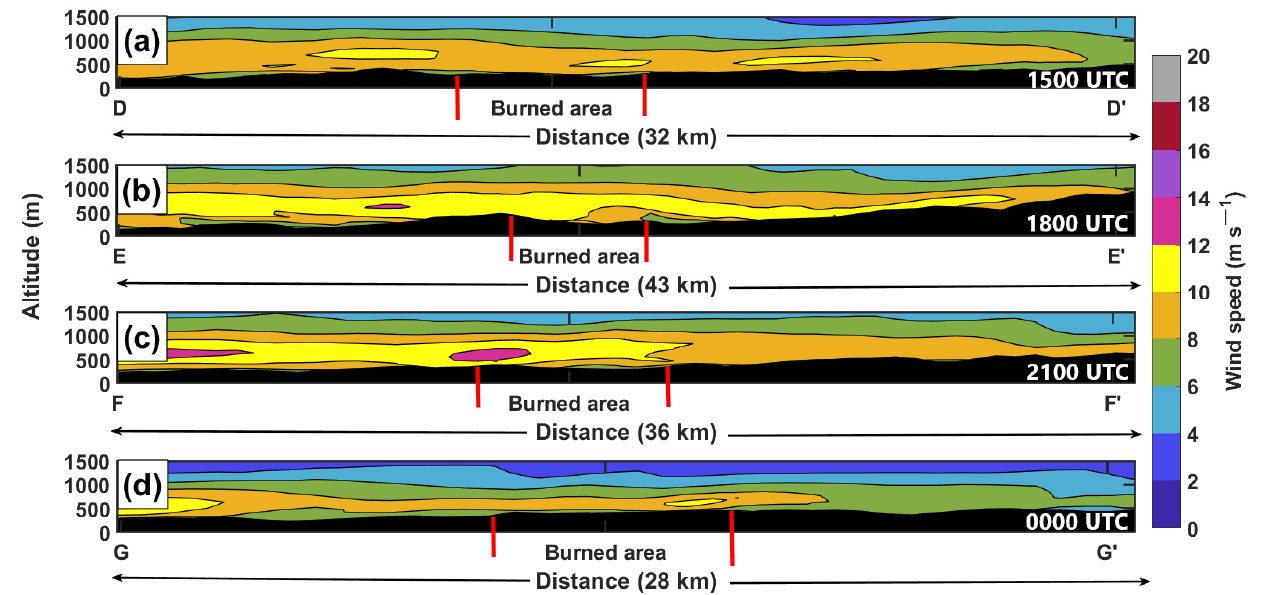
Figure 9. Wind Speed (contours) along the vertical cross sections by EXP simulation on 20 July 2019 ( a ) at 1500 UTC, ( b ) at 1800 UTC, ( c ) at 2100 UTC ( d ), and at 0000 UTC, with the burned area (red markers). The vertical cross-sections D–D’, E–E’, F–F’ and G–G’ show the wind speed vertical cross-sections (see Figure 2a for locations).